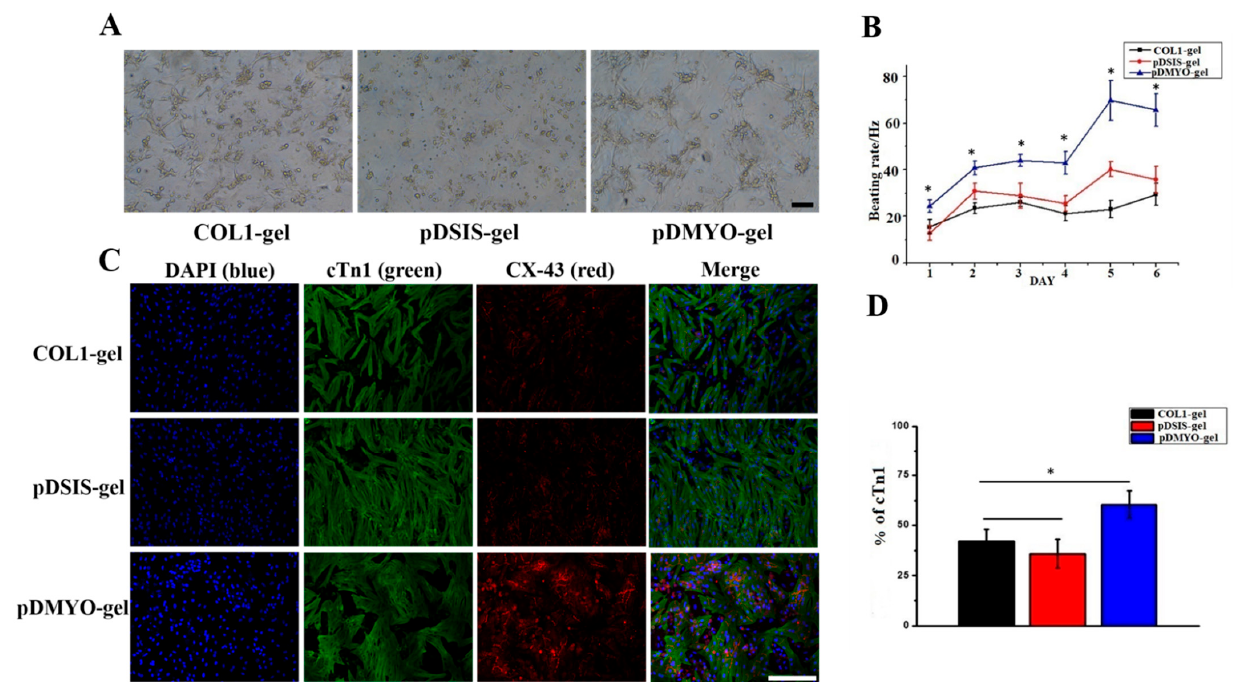
Figure 3. Effects of decellularized matrix and collagen hydrogel on cardiomyocytes morphology and function. ( A ) Video capture of beating cardiomyocytes after seven days in culture on different hydrogels; scale bar = 100 µ m; ( B ) Effect of decellularized matrix and collagen hydrogels on cardiomyocyte beating rate; ( C ) Immunofluorescence staining of cardiomyocytes for cTn1 (green) and Cx43 (red), scale bar = 500 µ m; ( D ) Statistical analysis of cTn1 expression. * denotes statistical difference within the same group with p < 0.05, respectively ( n > 3).